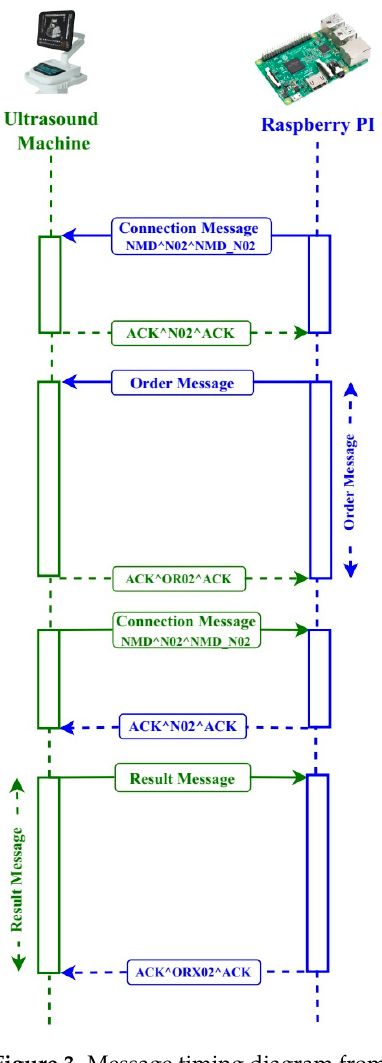
Figure 3. Message timing diagram from an ultrasound machine to Raspberry Pi.